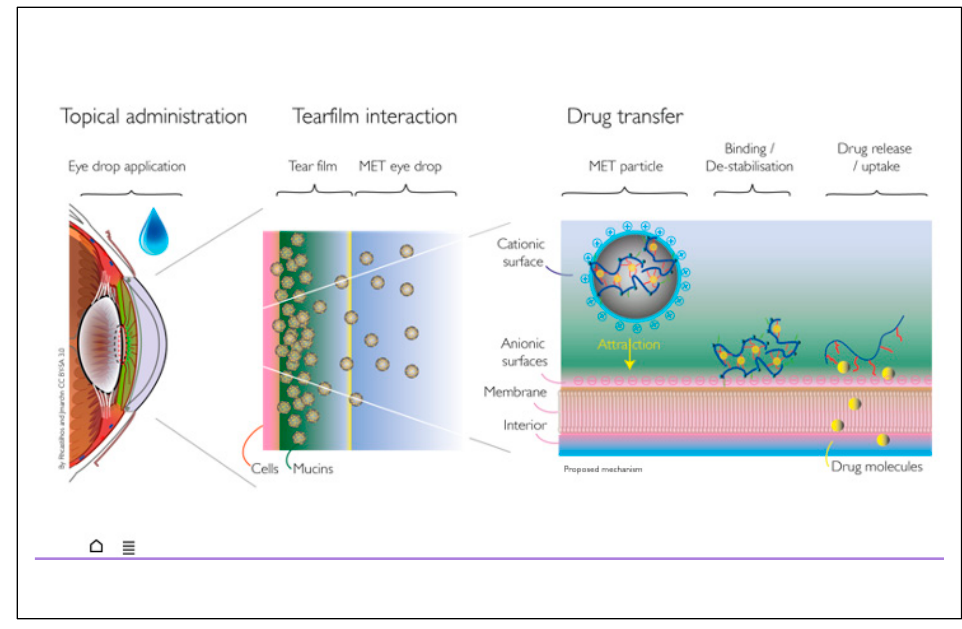
Figure 3. Hypothesised mechanism of action involving mucoadhesion and destabilization of drug carrying nanoparticles at the ocular surface. Table 10. Comparative drug deposition levels in the conjunctiva and cornea following the administration of a single topical ocular dose of various cyclosporine formulations.